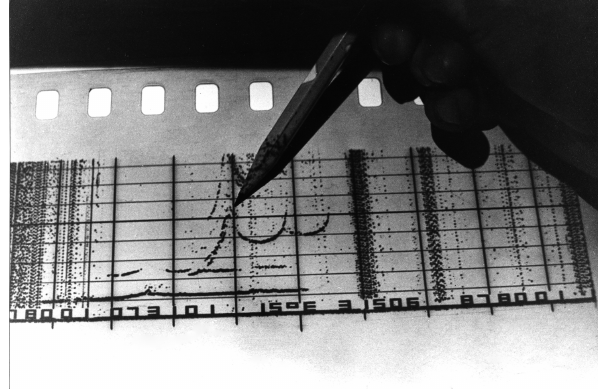
Figure 23. Ionogram processing by means of enlarger. Type of ionosonde: SP-3, Juliusruh,